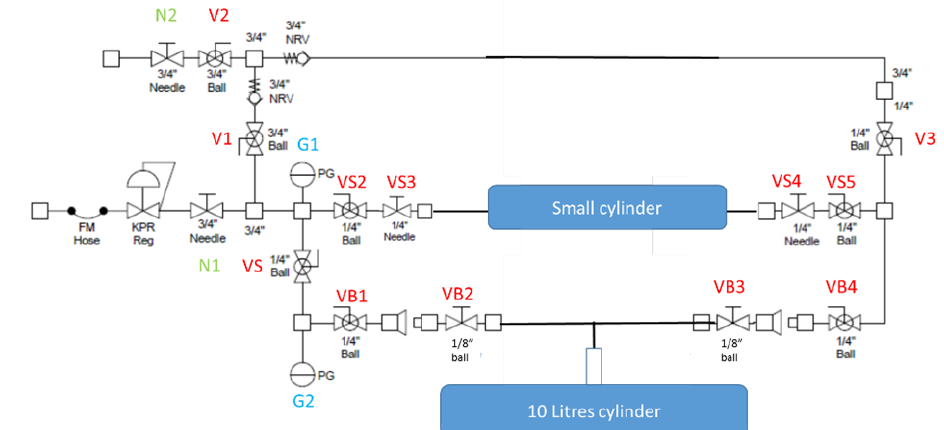
Figure 2. Schematic of the sampling system used to obtain representative hydrogen fuel sample from the FCEV at low-pressure point close to the vehicle fuel tank. V1, V2, V3, VS2, VS5, VB1, VB2, VB3 and VB4: two-way valve; N1, N2: metering valve (needle valve); VS3, VS4: small cylinder valve (metering valve); small cylinder was double-ended 1–4 L cylinder (i.e., 4 L sulfinert coated stainless steel vessel (Restek, UK));10 litres cylinder is 10 L aluminum treated Spectraseal ® cylinder (BOC, Woking, UK).